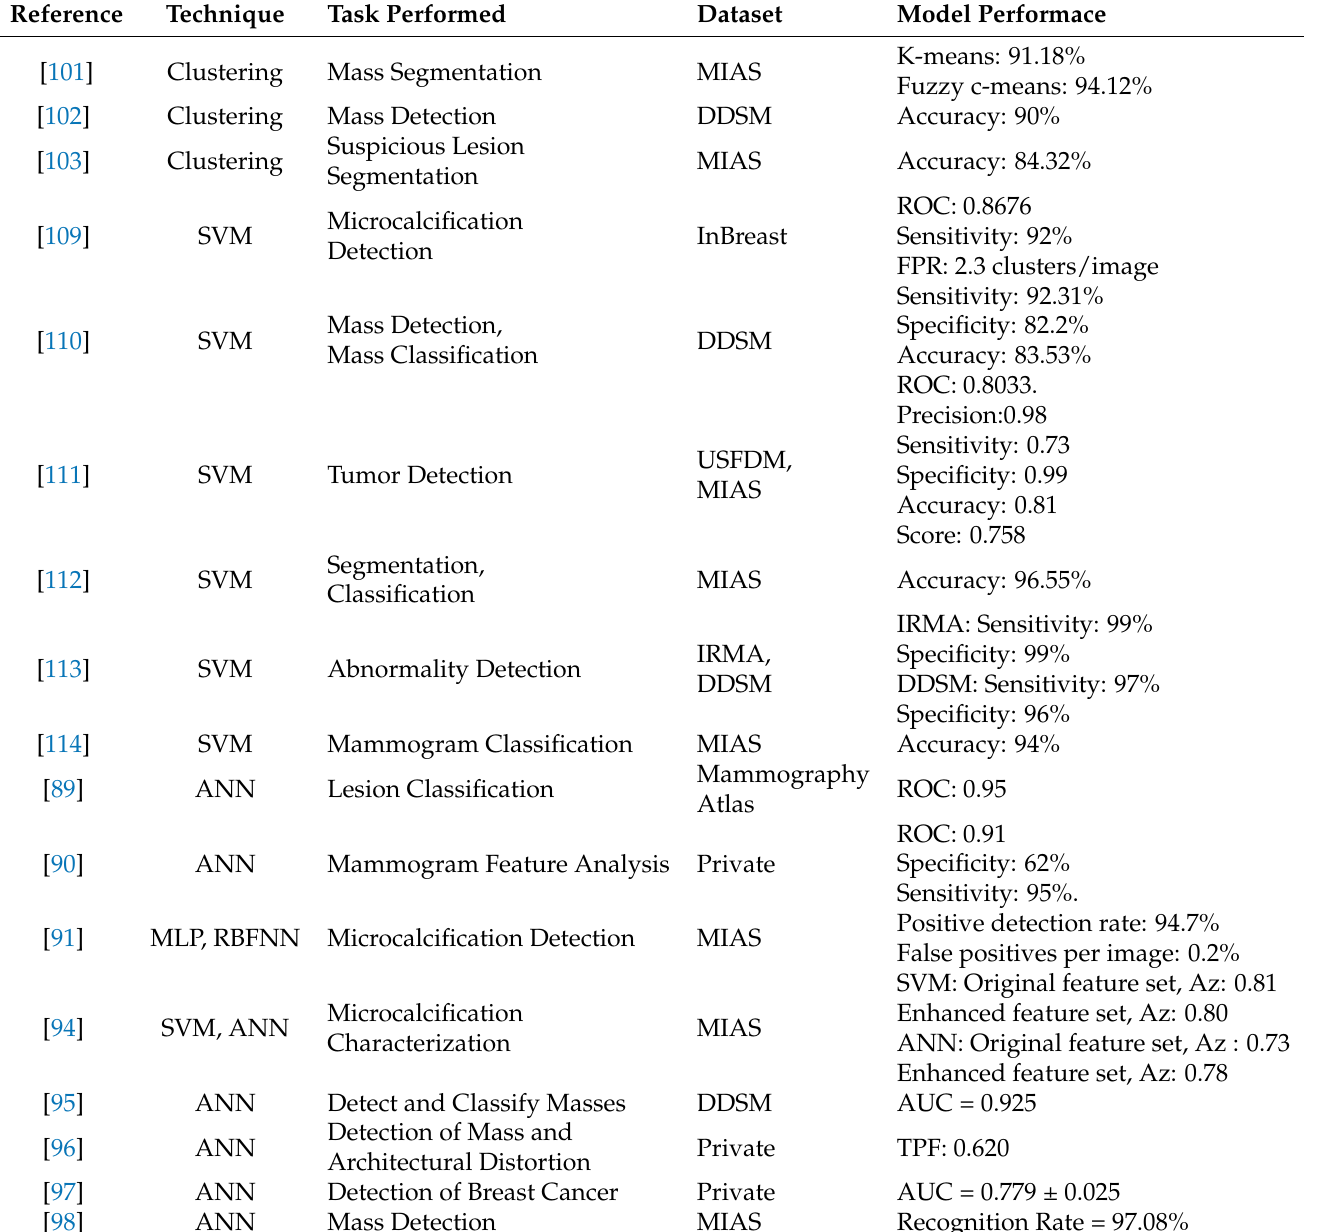
Table 4. Machine learning approaches for breast cancer diagnosis from